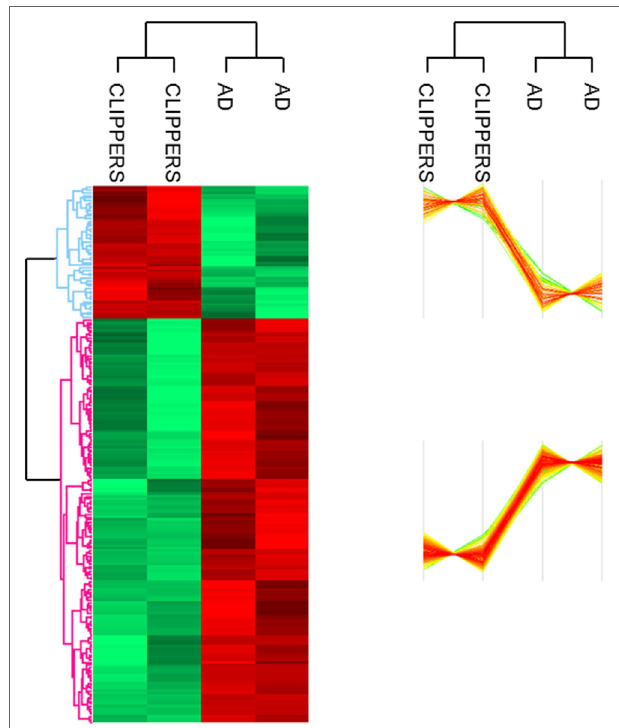
FigUre 1 | Proteomics of the cerebrospinal fluid in patients with chronic lymphocytic inflammation with pontine perivascular enhancement responsive to steroids (CLIPPERS). LC–MS/MS proteomics of the cerebrospinal fluid obtained from patients with CLIPPERS and Alzheimer disease was performed and compared as described in Section “Materials and Methods.” Heat maps of proteins discriminating between the two diseases are shown (red: upregulated, green: downregulated). The corresponding proteins are listed in Table S1 in Supplementary Material in the same order; upregulated proteins with functions are also indicated in Table 2